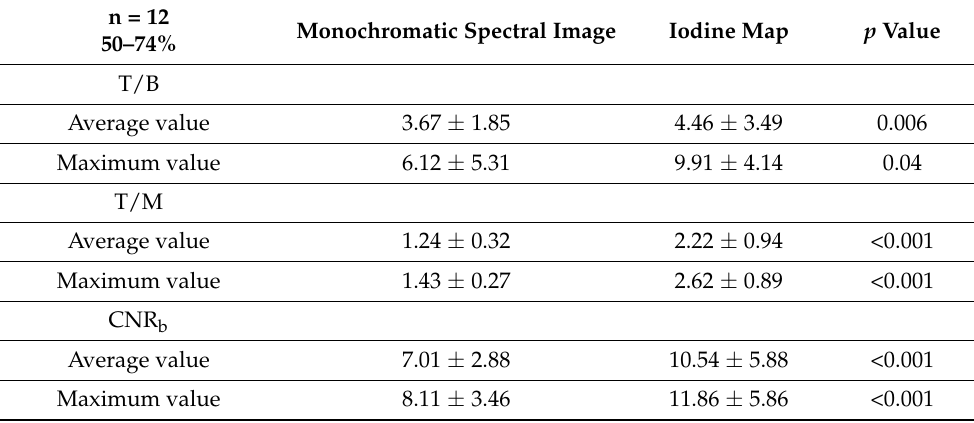
Table 5. Comparison of T/B, T/M, and CNR b obtained from the monochromatic spectral images and iodine maps for breast density of